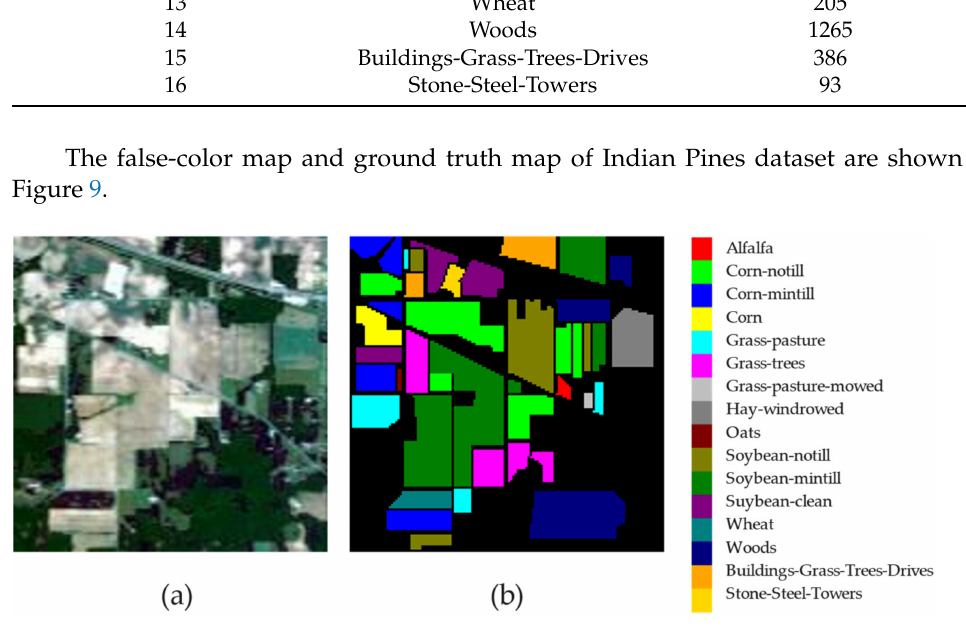
Figure 9. Indian Pines dataset: ( a ) false-color map, ( b ) ground truth